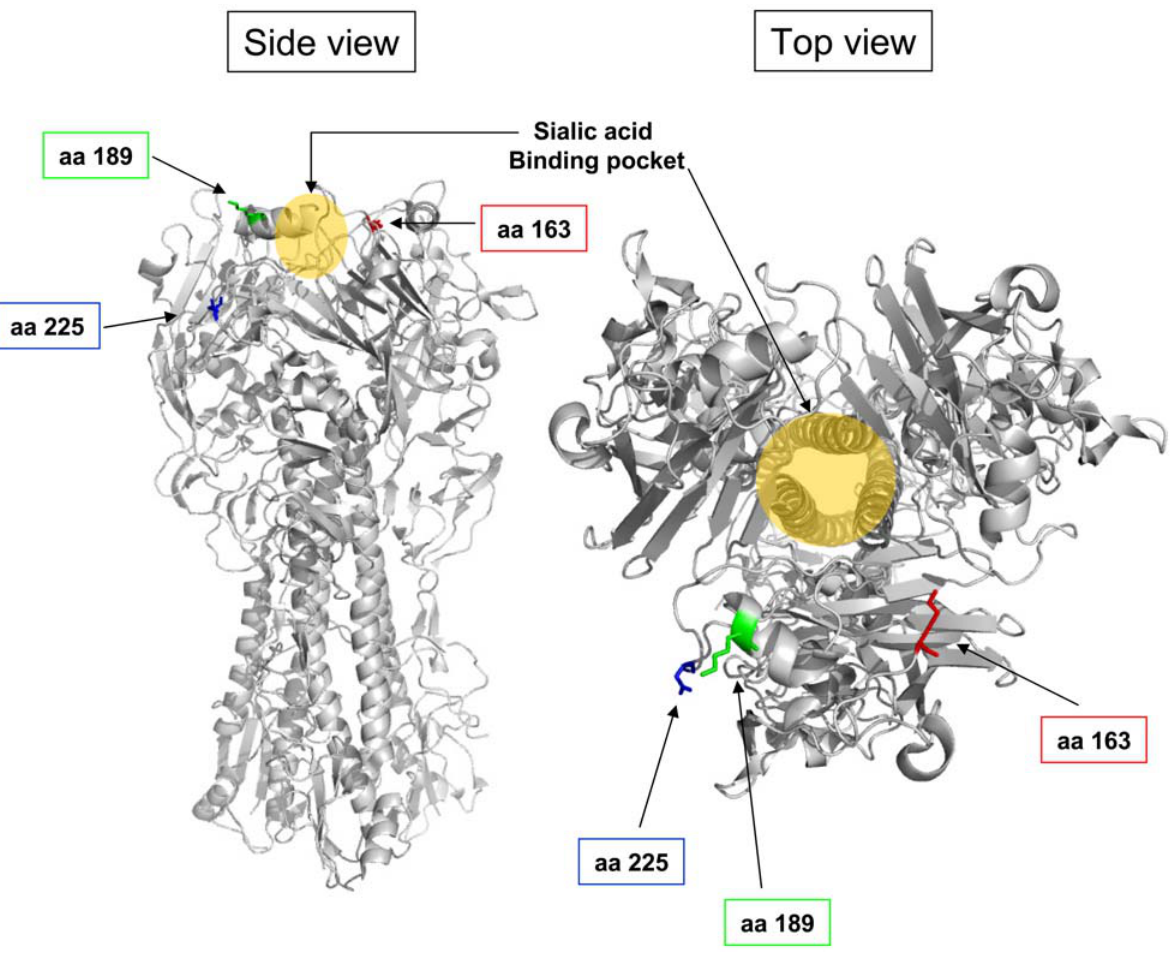
Figure 2. Location of hemagglutinin mutations specific to isolates with reduced zanamivir sensitivity. The amino acid positions for the mutations listed in Table 3 were located on the published crystal structure of an IFV A H1 trimer (1RU7). Amino acid 163 is shown in red, 189 in green, and 225 in blue. Left panel shows a side view of the HA trimer (with sialic acid binding site on top and membrane-proximal region on bottom) and right panel shows a top down view of the HA trimer. Approximate site of sialic acid binding is indicated with arrows and yellow shaded area.